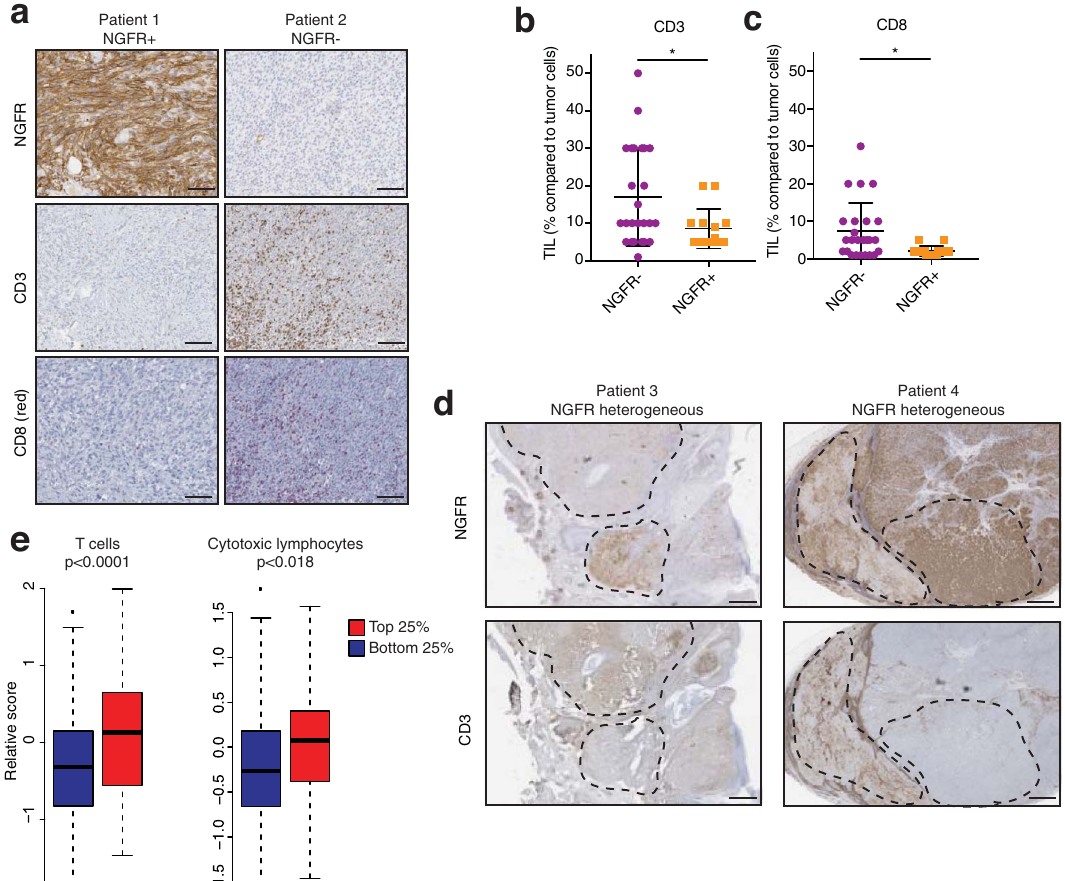
Fig. 5 NGFR hi melanoma fractions show immune exclusion in patients. a Examples of two melanomas from patients showing either high or low NGFR expression, and the corresponding CD3 and CD8 stainings for the same regions. Scale bars indicate 50 μ m. Quanti fi cation in b , c . b , c CD3 and CD8 scores for NGFR neg vs. NGFR pos samples. Only tumor-in fi ltrating lymphocytes were scored and compared with the relative abundance of tumor cells. Error bars represent S.D. Statistical analysis by Mann – Whitney test; * p < 0.05. d Examples of two melanomas from patients that are heterogeneous for NGFR expression within each sample, and the corresponding CD3 stainings for the same regions (indicated by dotted lines). Scale bars indicate 100 μ m. e MCP counter analysis on melanoma cohort of TCGA divided in top and bottom 25% NGFR-expressing tumors. Gene sets for “ T cells ” and “ cytotoxic lymphocytes ” are plotted. Error bars represent S.D. Statistical analysis by unpaired t -test. Source data are provided as a Source Data fi